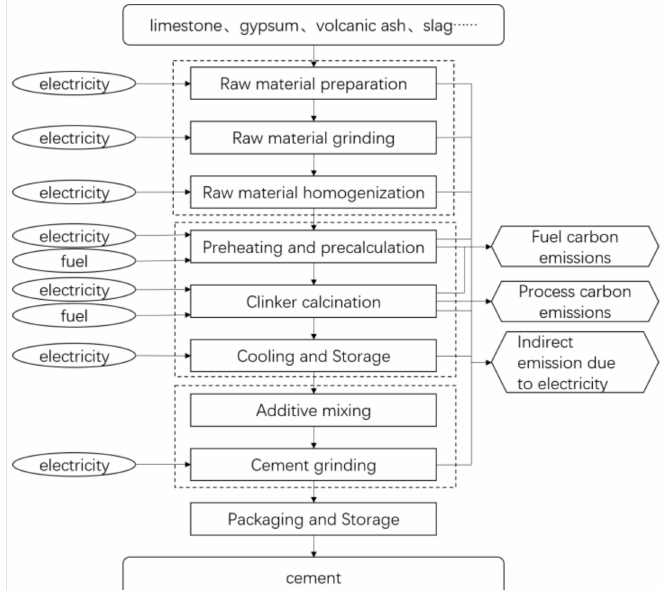
Figure 3. Cement production process flow